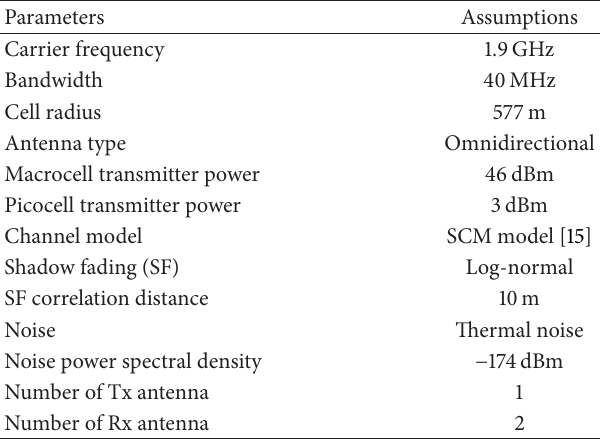
Table 2: Simulation parameters.